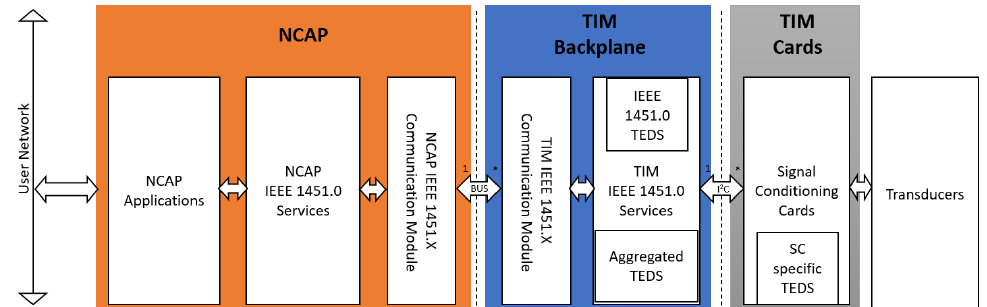
Figure 5. Architecture Model Proposal, built around IEEE 1451.0’s reference